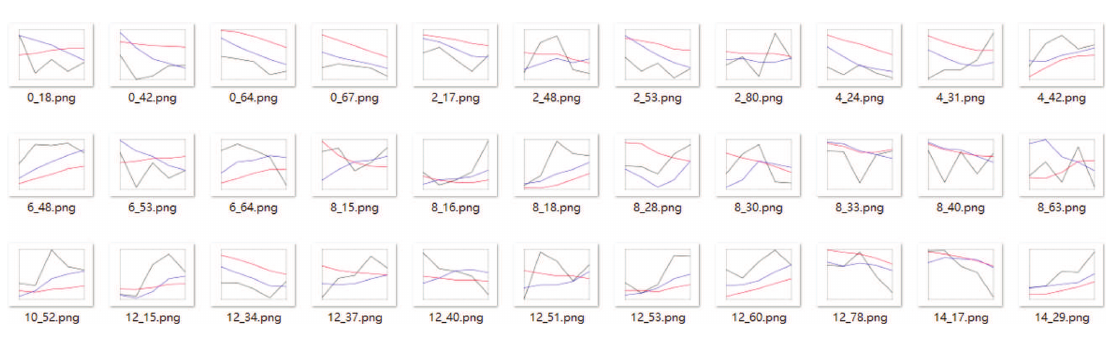
Figure 26: Experiment 2 with Label 0.